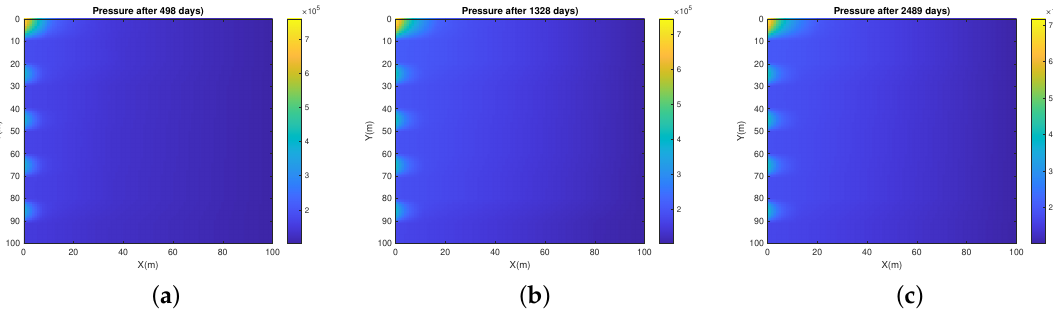
Figure 6. Pressure at different time for Example 2: ( a ) Pressure ( after 498 days). ( b ) Pressure (after 1328 days). ( c ) Pressure (after 2489 days).